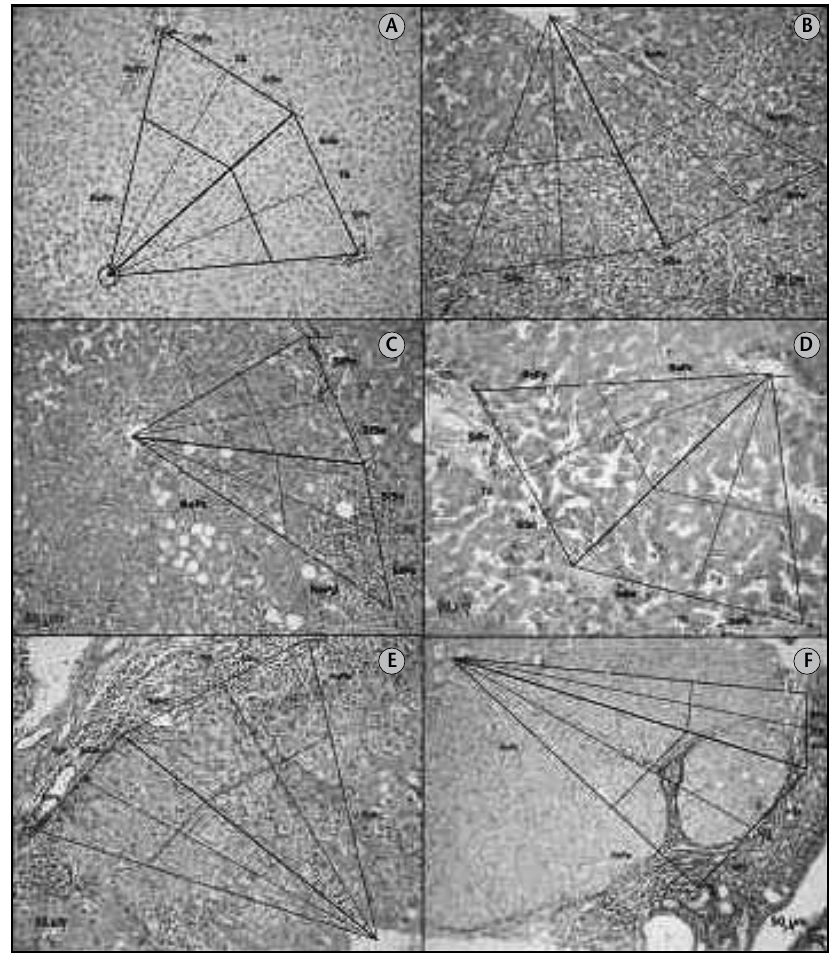
Figura 3 – GEM inserida à imagem de corte histológico de fígado no software Microsoft ® PowerPoint (A) fígado humano. Observar a veia centrolobular e os espaços porta como pontos de referência (HE, aumento original 100×); (B) caso 1 – triângulos TA e TB ajustados delimitando regiões metabólicas e padrões circulatórios; duas áreas metabólicas (RePp e RePc) podem ser definidas com a GEM. Hepatócitos com frequentes macrovacúolos e microvacúolos em RePp, atrofia e necrose hepatocelular com proliferação e expansão do conjuntivo porta no septo virtual interlobular (SiPo/SiSe) (HE, aumento original 200×); (C) caso 2 – notar congestão dos sinusoides e alargamento dos espaços porta, com infiltrado mono e polimorfonuclear e vacuolização zonal; a GEM revela